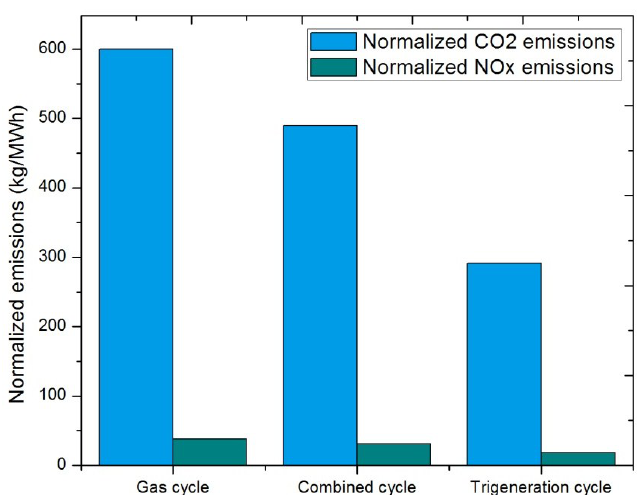
Figure 16. Normalized CO 2 and NO x